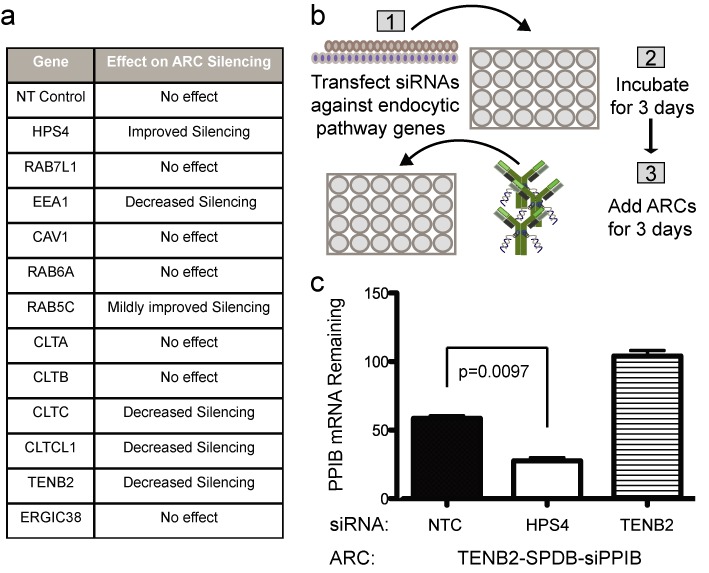
siRNA screen of endocytic pathway components reveals that HSP4 inhibition improves ARC-mediated silencing efficiency. (a) List of genes targeted in the candidate-based siRNA screen and the observed phenotypes following knock down. (b) Schematic of the experimental approach. We transfected TENB2-PC3-High cells with siRNAs against endocytic pathway genes and incubated for 3 days. We then added anti-TENB2-SPDB-siPPIB ARCs to the cells and assayed ARC-mediated silencing of PPIB mRNA after 3 additional days. (c) ARC-mediated silencing of PPIB mRNA after initial transfection with siRNA targeting HPS4, siRNA targeting TENB2 (control, to reduce levels of the antibody target) or non-targeting control (NTC) siRNA (SD shown, N = 4).